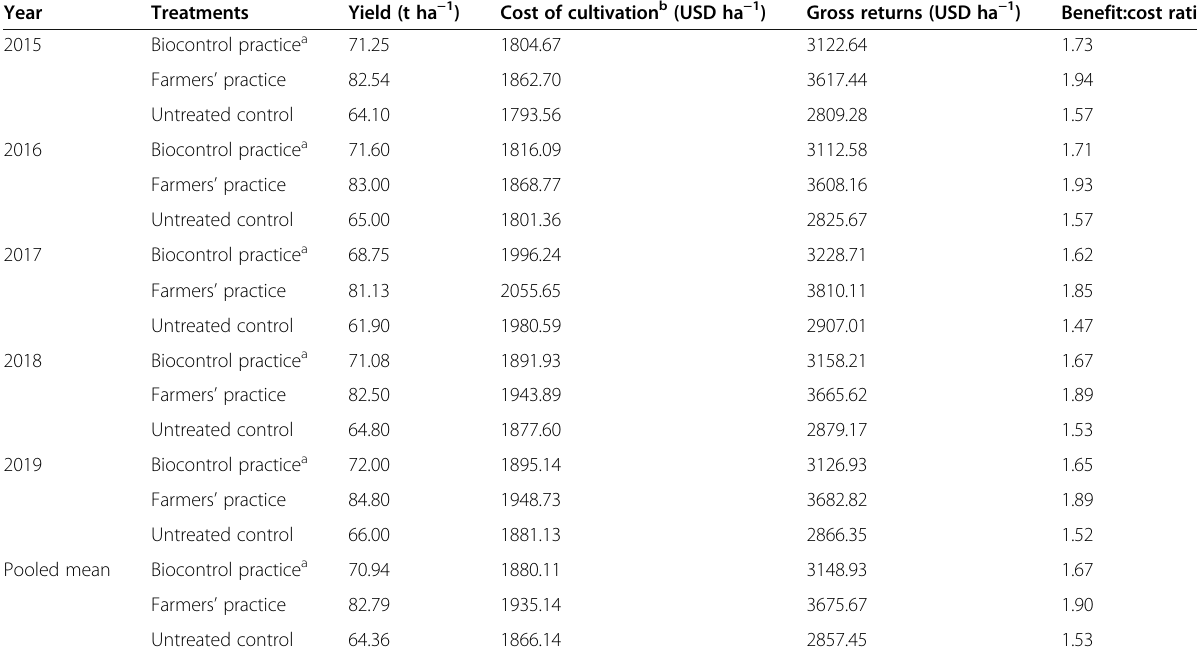
Table 4 Cost of cultivation and economics returns from various treatments in the management of S.